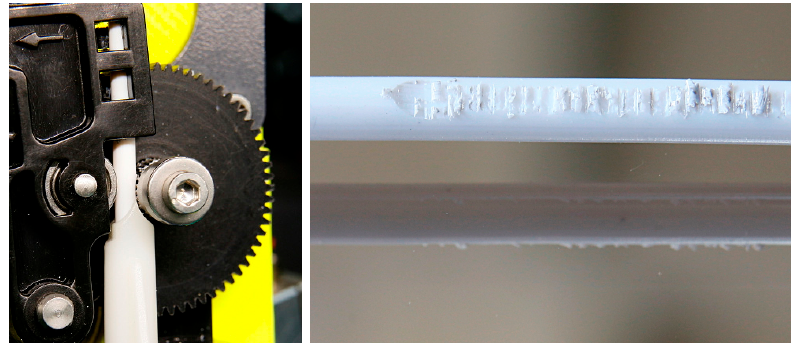
Figure 7. Grinding of a filament containing 60 vol % alumina.